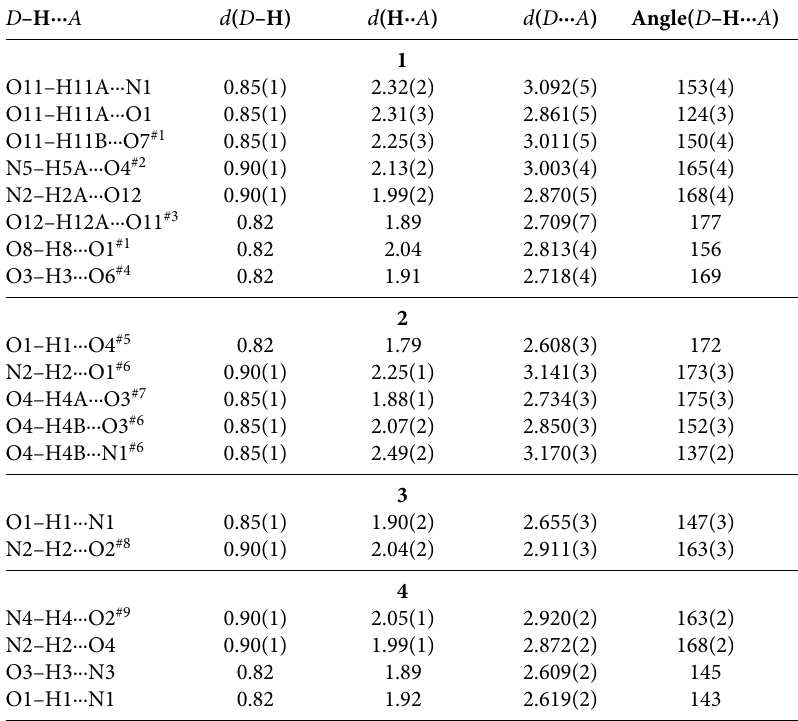
Table 2. Hydrogen bond distances (Å) and bond angles (°) for the compounds. D –H∙∙∙ A